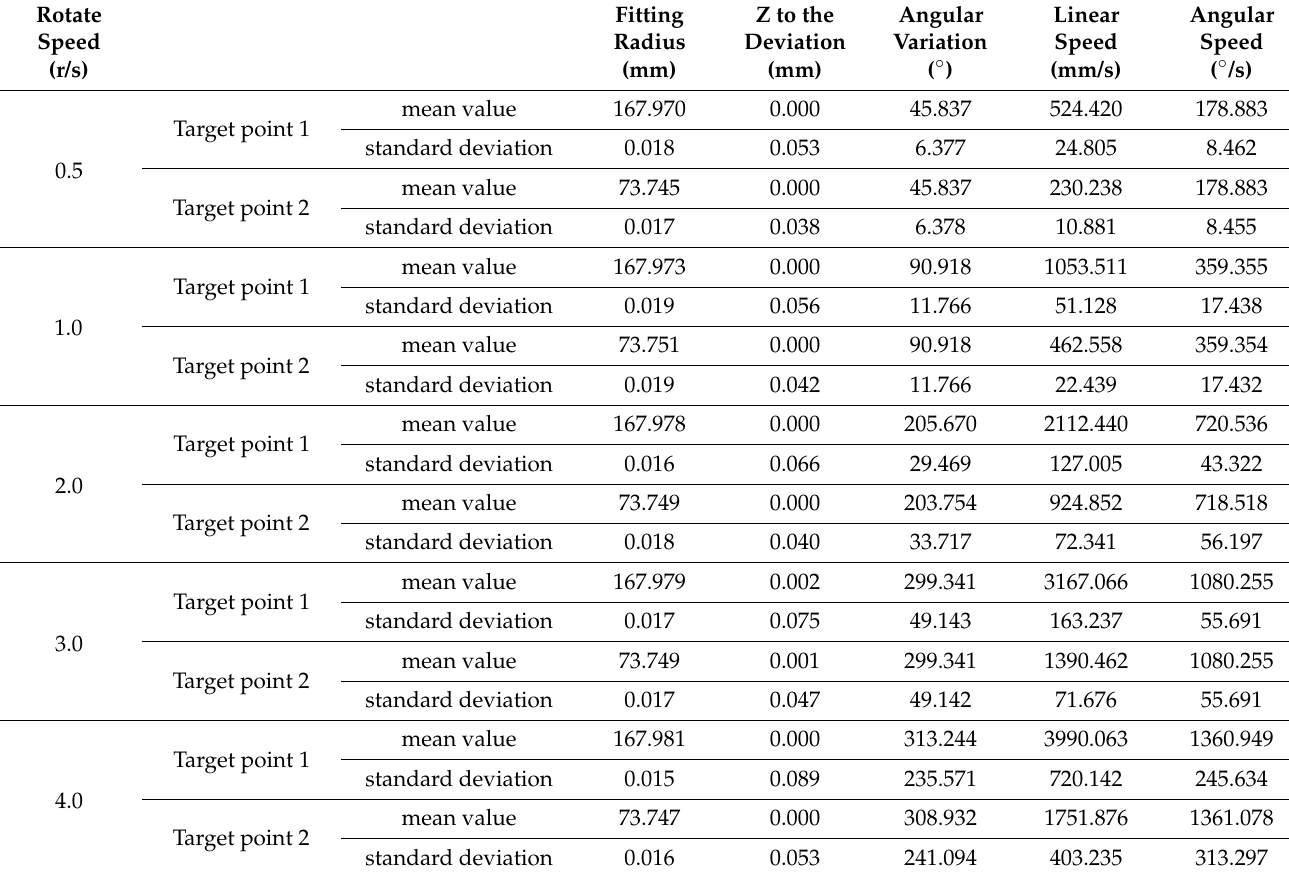
Table 4. Calculation results at different